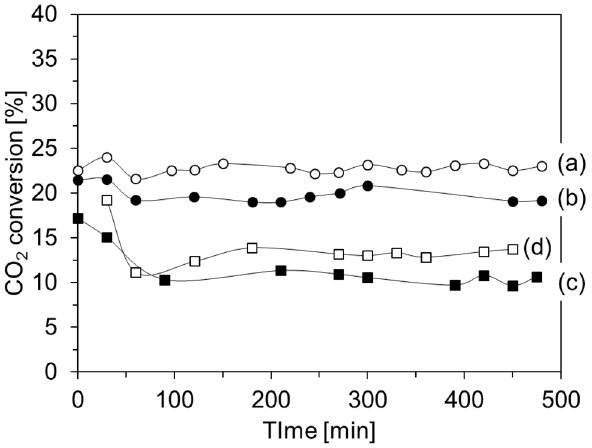
Figure 4. Time course of CO 2 conversion over pristine F04M catalyst (a) and F04M catalyst coated with silica (b), zirconia (c), and titania (d). Reaction conditions: 523 K, 3 MPa, W/F = 5 g·h − 1 ·mol − 1 , H 2 /CO 2 /Ar = 72/24/4 (molar ratio). Table 1. Product selectivity over the various catalysts.